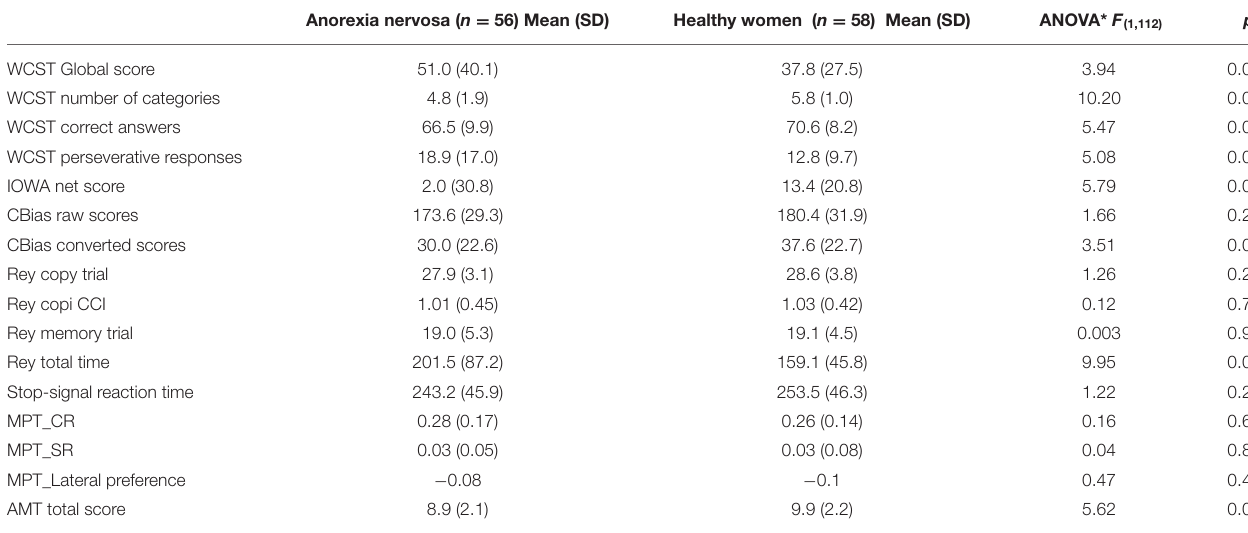
TABLE 2 | Neuropsychological tasks in patients with AN and healthy